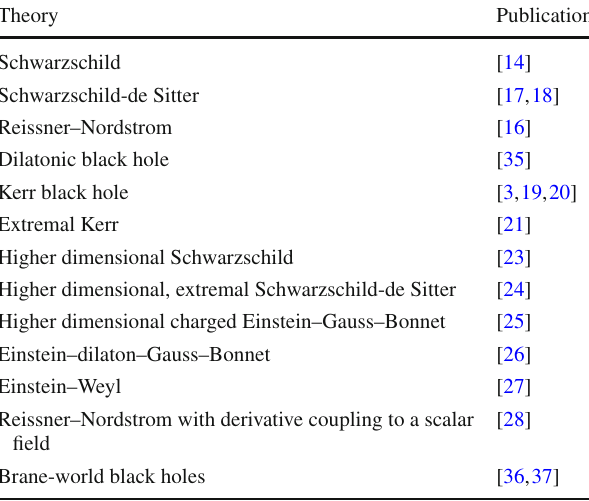
Table 1 Analytical results for the eikonal quasinormal